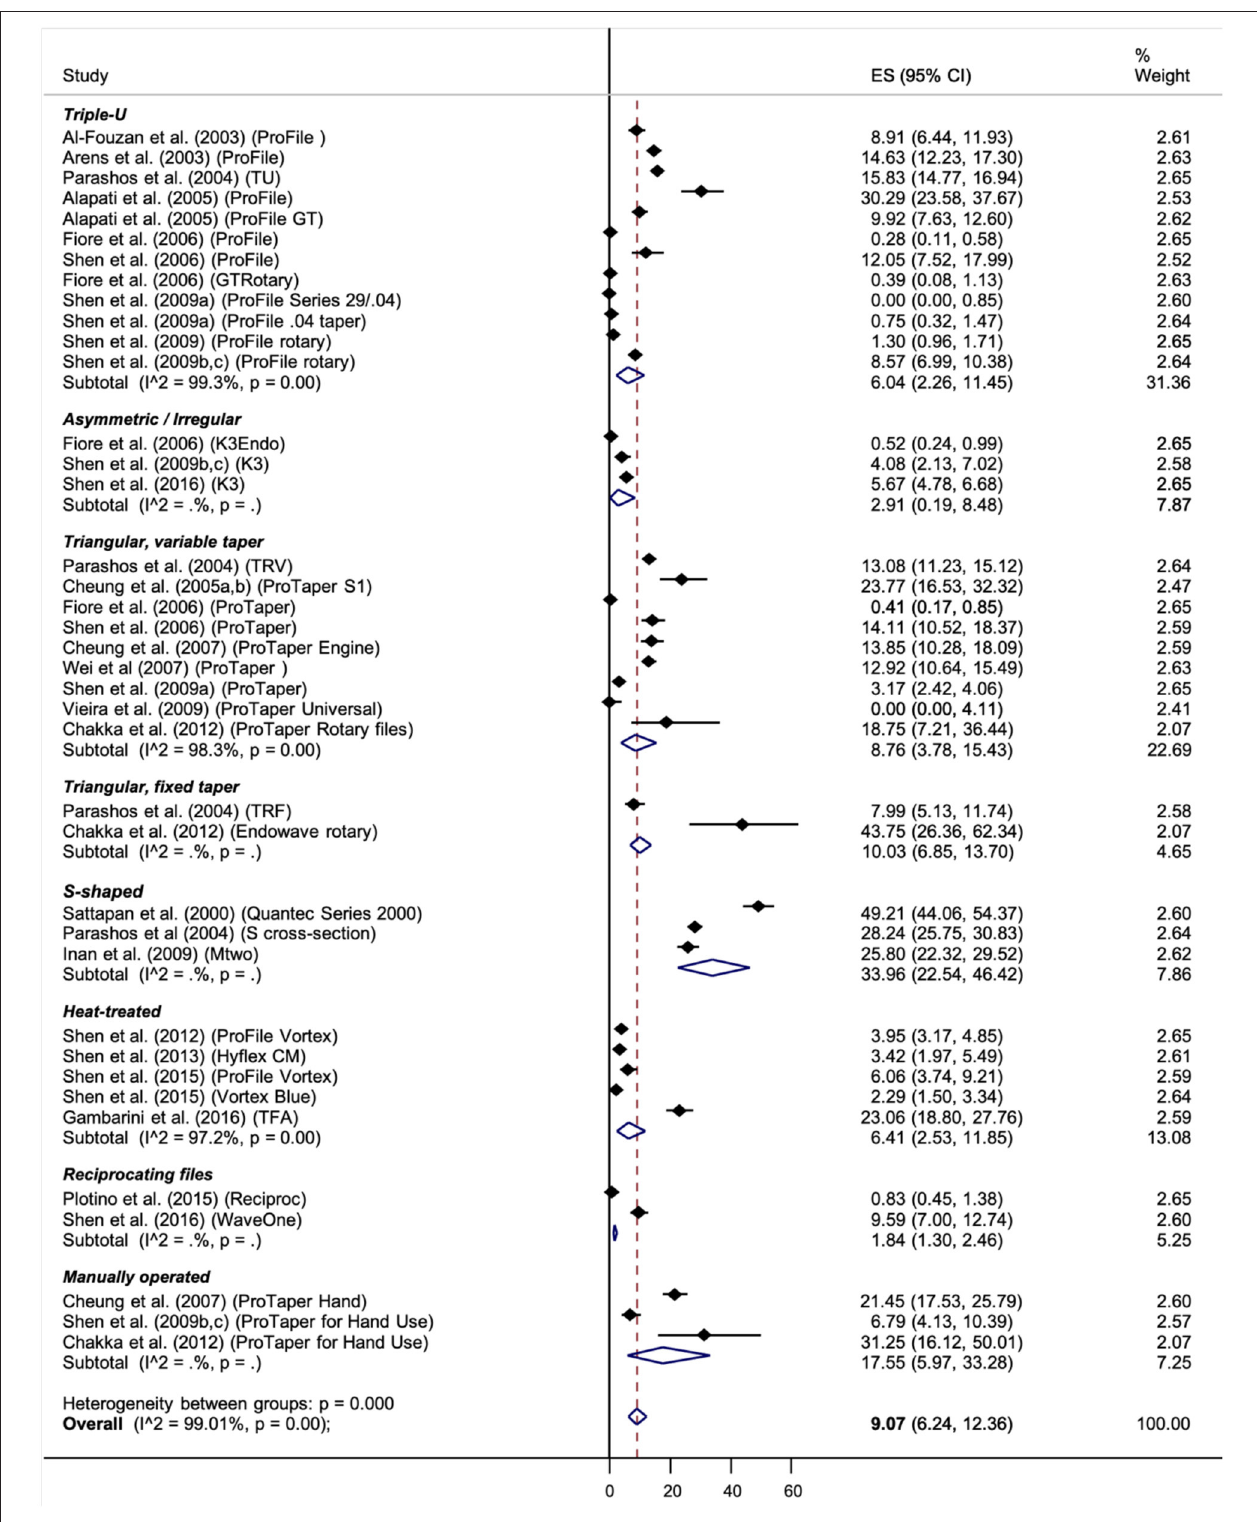
FIGURE 2 | Forest plot for all kinds of defect, inclusive of plastic deformations and instrument separations, from reports included in the meta-analysis. [NB: X-axis represented the percentage of the total number of files reported].